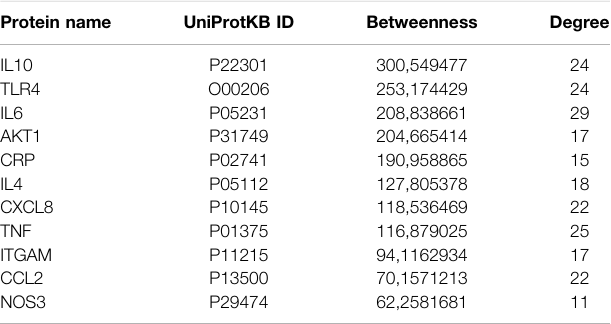
TABLE 2 | Proteins with highest than average betweenness and degree in the protein-protein functional interaction network. Protein